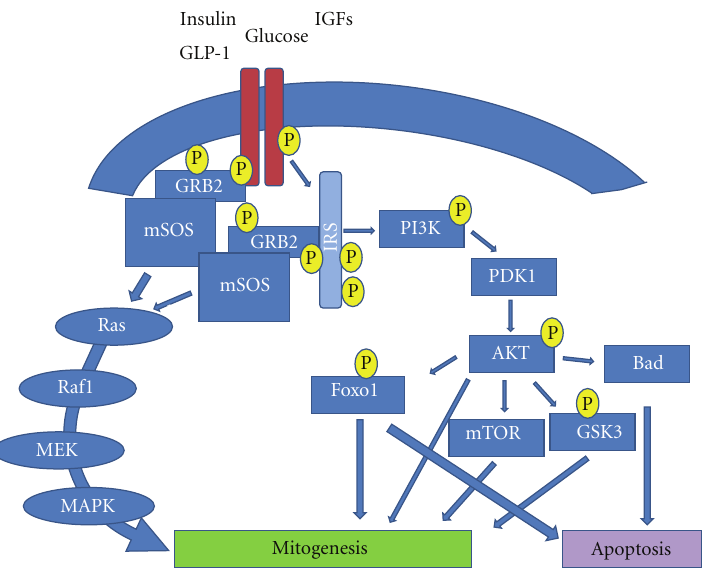
Figure 2: Schematic representation of PI3K/Akt and MAPK signalling. Mechanisms of some growth factors modulate beta-cell replication through proliferation or apoptosis. These factors on one hand stimulate PI3K, AKT, MAPK, and increase beta-cell proliferation. On the other hand, stimulate AKT, FOXO1, and other proapoptotic molecules resulting in induction of apoptosis.